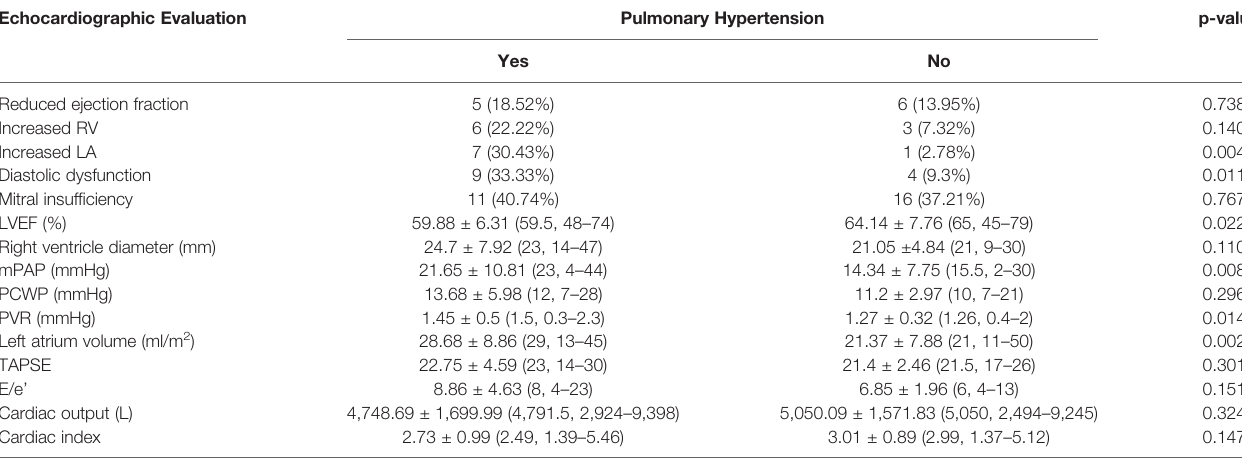
TABLE 4 | Comparative analysis between the parameters used in the echocardiographic evaluation of patients with Graves ’ disease according to the presence of Pulmonary Hypertension. Echocardiographic